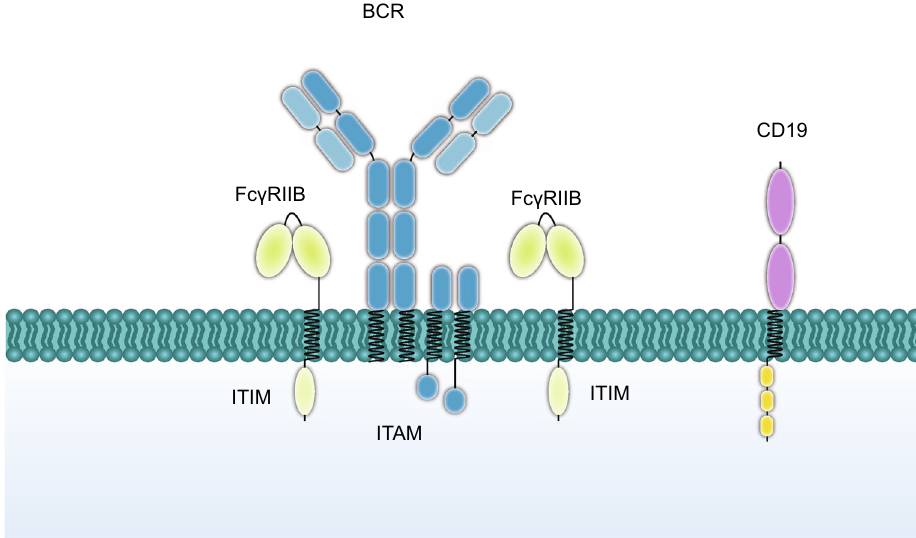
Figure 3. A CD19-blocking model that reveals the inhibitory function of Fc γ RIIB. The Fc γ RIIB can inhibit B cell activation by preventing CD19, which is an activating co-receptor, from colocalizing with BCR microclusters. The impaired function of Fc γ RIIB- I232T can also be explained as the failure in blocking the colocalization.